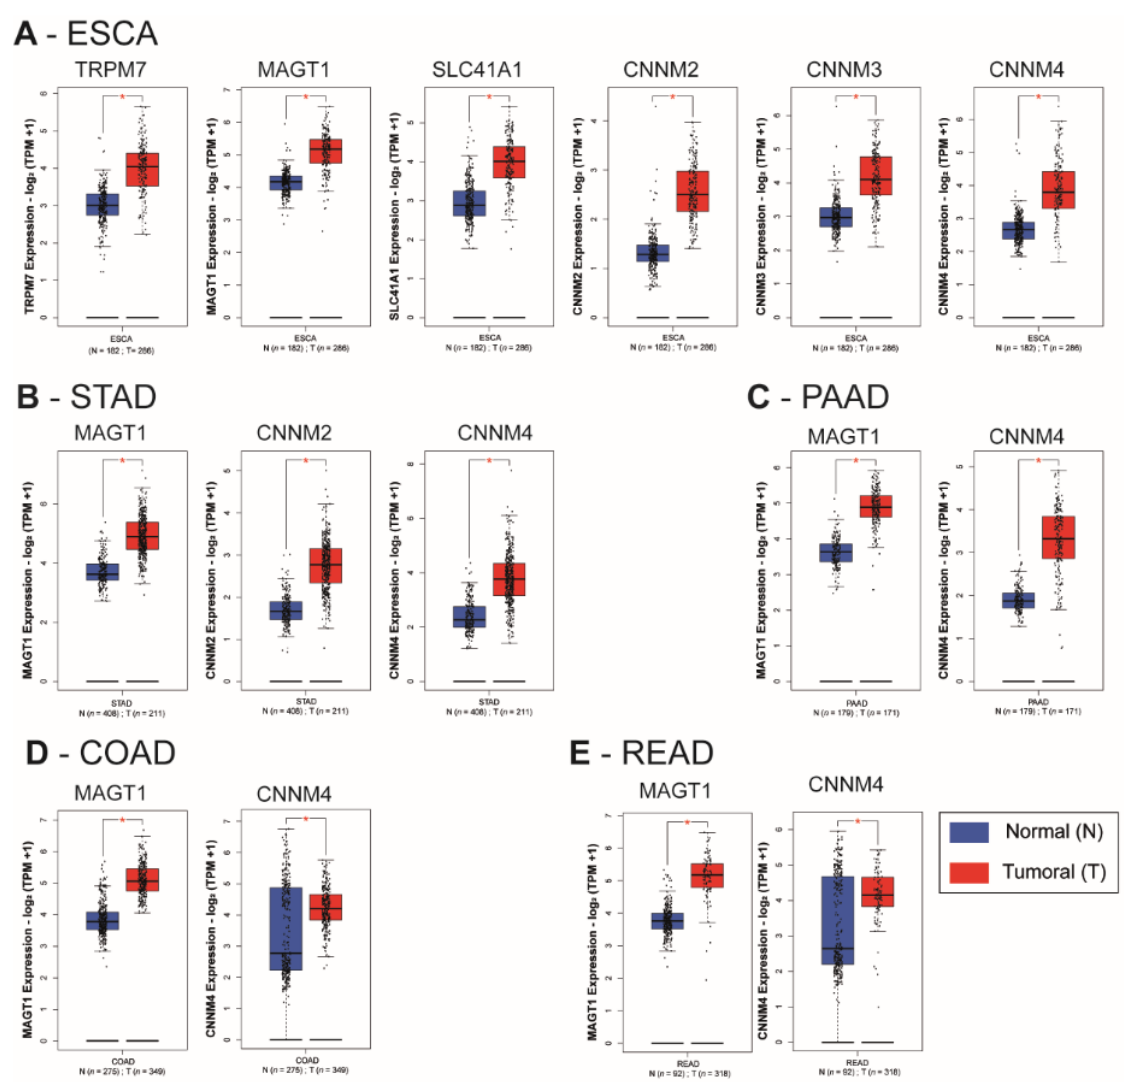
Figure 3. Relative mRNA expression of magnesium transporters in digestive cancers and normal tissues. Whiskers boxplots for Mg 2+ transporters mRNA (TRPM6, TRPM7, MAGT1, SLC41A1, MRS2, CNNM1, CNNM2, CNNM3, CNNM4) were generated using GEPIA2 from The Cancer Genome Atlas (TCGA) and Genotype-Tissue Expression (GTEx) samples. TCGA datasets were ( A ) Esophageal carcinoma (ESCA), ( B ) Stomach Adenocarcinoma (STAD), ( C ) Pancreatic Adenocarcinoma (PAAD), ( D ) Colon Adenocarcinoma (COAD) and ( E ). Rectum Adenocarcinoma (READ). TRPM7, Transient Receptor Potential Cation Channel Subfamily M, Member 7; MAGT1, Magnesium Transporter 1; SLC41A1, Solute Carrier Family 41, Member 1; MRS2, Mitochondrial RNA Splicing Protein 2; CNNM4, Cyclin and CBS Domain Divalent Metal Cation Transport Mediator 4; n = number of samples; N, normal; T, tumoral. Relative mRNA levels are expressed as log2 transcripts per million bases (TPM). Only significative results (* p < 0.01) are presented. The whole dataset analysis is provided as supplementary data (Supplementary Figure